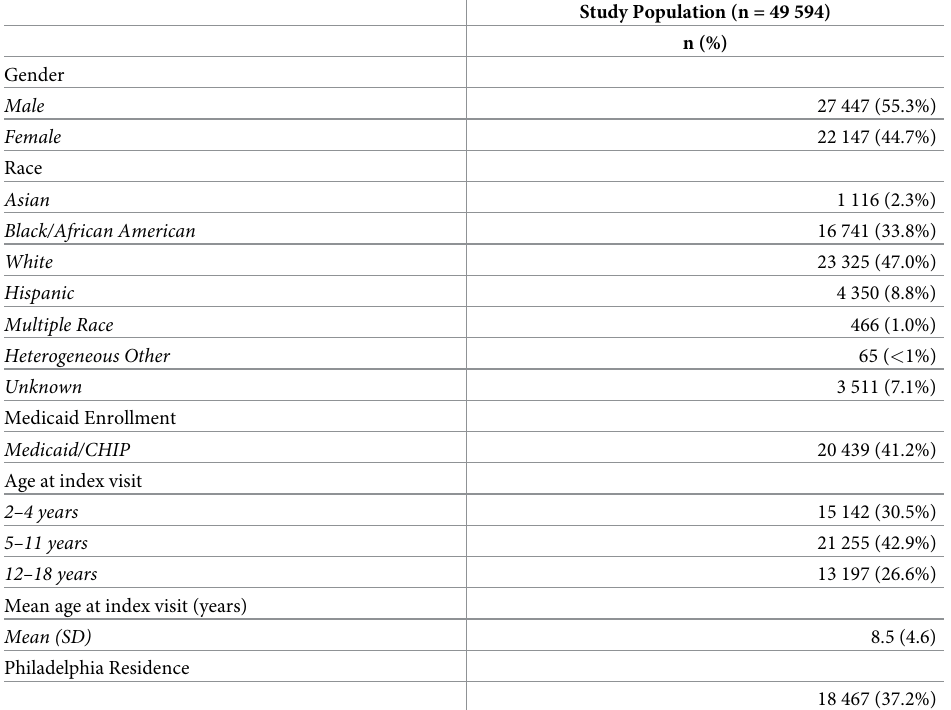
The demographic analysis of patients in the LCA-derived classes indicated that females tended to have higher rates of gastrointestinal issues; they comprised a majority of patients in Class 6. Males had a much higher prevalence of neurodevelopmental disorders. More than three quarters (77.6%) of patients in Class 7 were male. More than half of patients in Class 4 (Asthma) were African American (52.8%), despite African American patients comprising approximately one third of the total study population. African American patients comprised similarly high proportions of patients in Class 2 (45.2%) and Class 8 (41.4%) (Class 2 and Class 8 were characterized by having a high prevalence of inflammatory skin conditions and physical symptoms respectively). Class 2, Class 4, and Class 8 also had high proportions of urban youth compared to the total study population. Table 5. Demographic Characteristics of Obesity Incidence Study